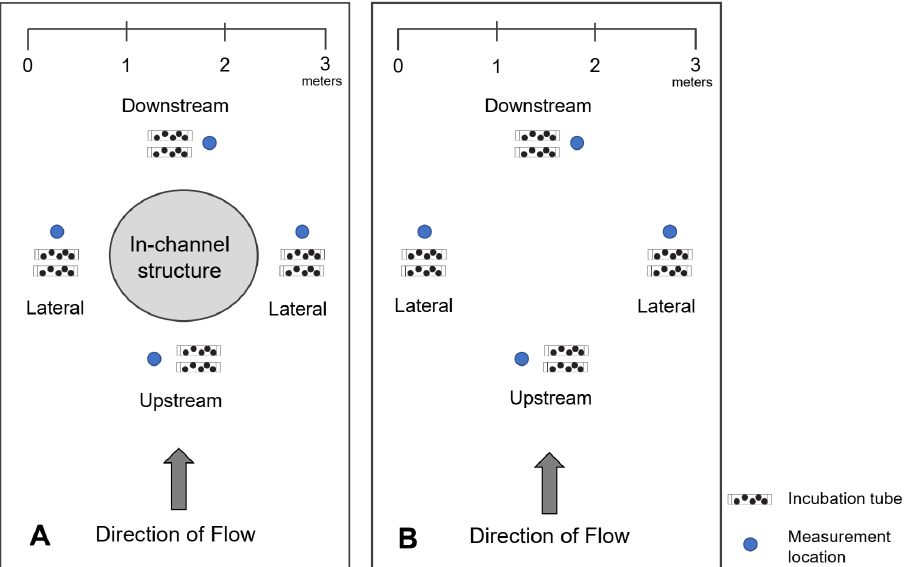
Figure 2. Schematic of measurement locations (upstream, lateral, and downstream) and incubation tubes designated around paired sites ( A ) containing in-channel structure and ( B ) lacking in-channel structure, on the lower Mokelumne River, California. A total of 8 egg tubes was placed around each site, two at each measurement location. Incubation tubes not drawn to scale.